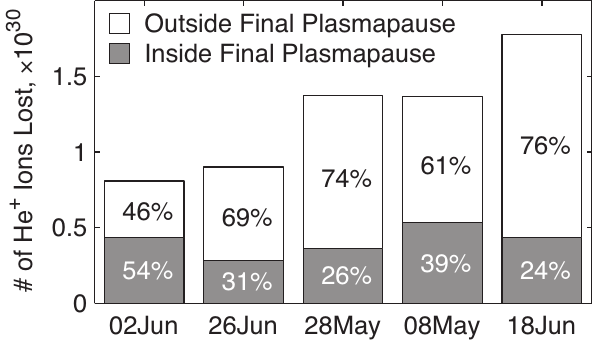
Fig. 5. The EUV images for 18 Jun 2001 with the final plasmapause location selected in the right image (red line) and overlaid on the initial plasmasphere image on the left (dashed red line).